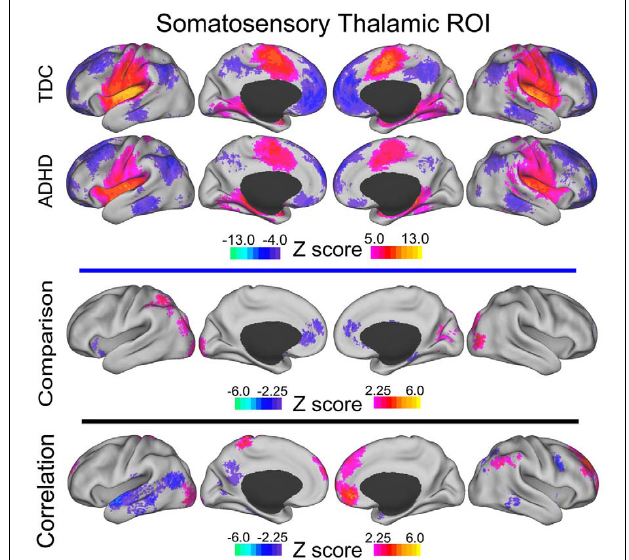
FIGUREA4 | Premotor–motor thalamic voxelwise maps projected onto cortical surfaces. Each row displays the cortical surface for each voxelwise map generated from the premotor–motor thalamic ROI: group maps for TDC, group maps for ADHD-C, maps from the comparative analysis (TDC vs. ADHD-C), and maps from the correlation analysis. Cortical surface projection was performed with the (PALS)-B12 atlas (Van Essen, 2005) and the software Caret (Van Essen et al., 2001).